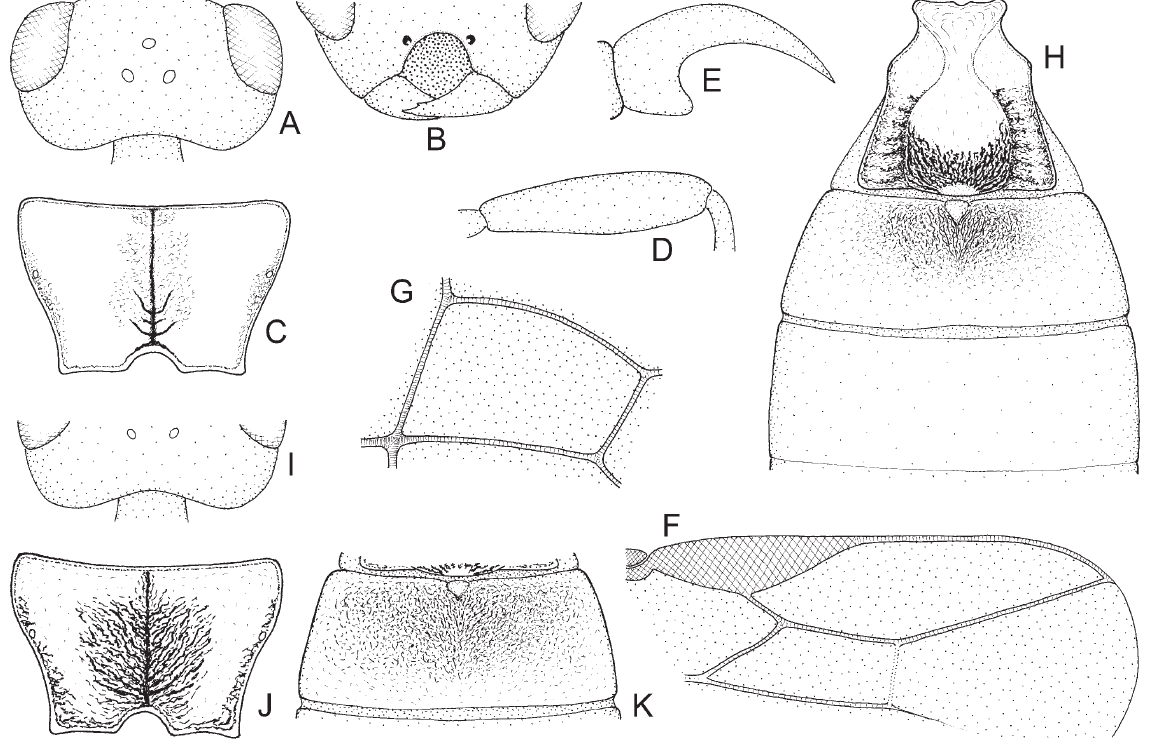
Fig. 12. Bracon ( Glabrobracon ) fuscicoxis Wesmael, 1838 (A-H: ♀ lectotype, I, K: ♂ paralectotype, J: ♂ paralectotype + ♀). A . Head in dorsal view. B . Head in frontal view. C . Propodeum. D . Hind femur. E . Claw. F . Distal part of right forewing. G . First discal cell of right forewing. H . Tergites 1-3. I . Temple in dorsal view. J . Propodeum. K . Second